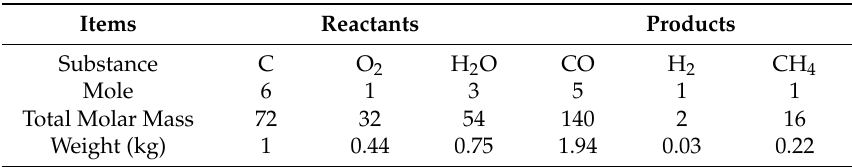
Table 1. Reaction in the gasifier.